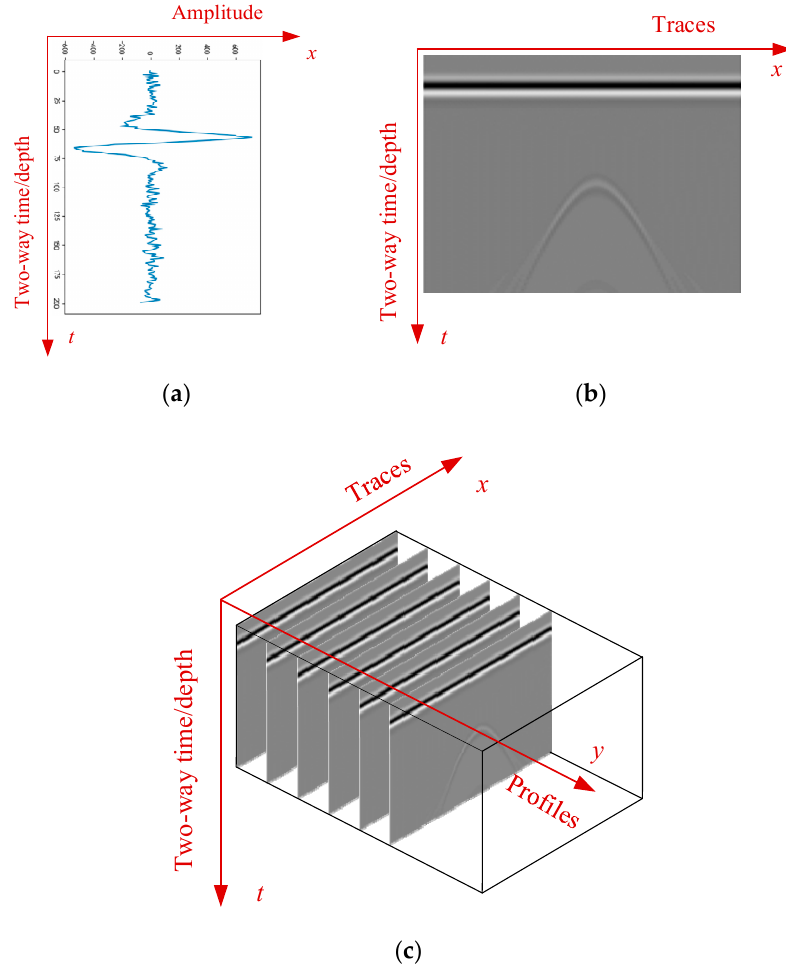
Figure 2. GPR data display. ( a ) A-scan; ( b ) B-scan; ( c ) C-scan.